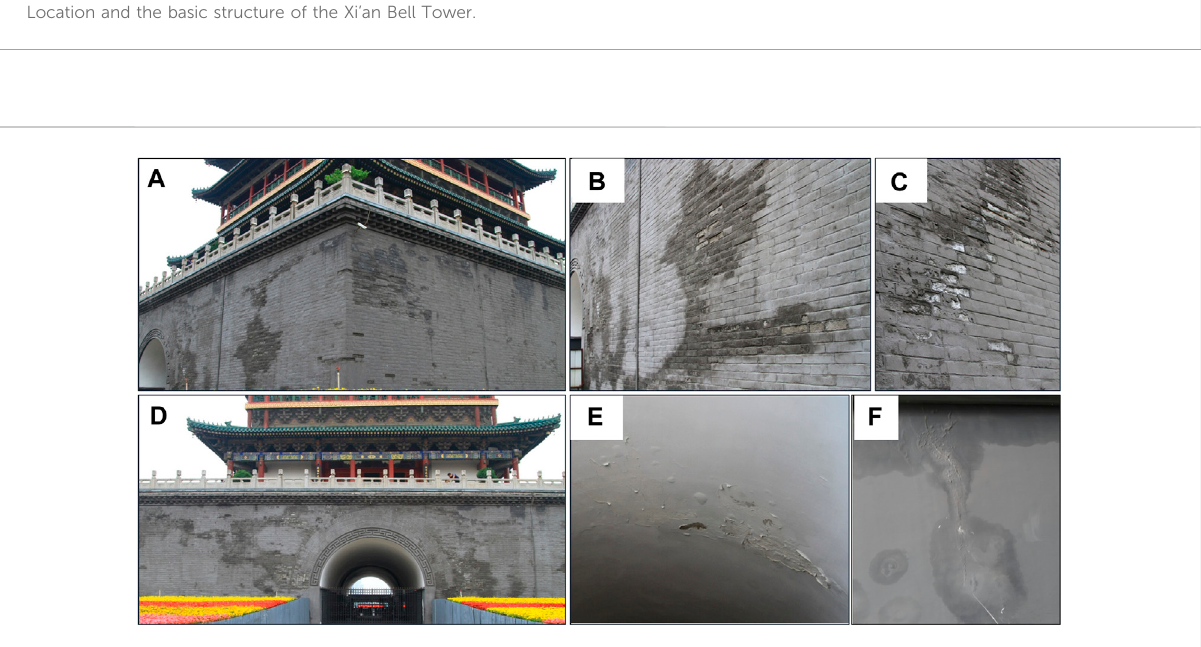
FIGURE 2 Waterseepage ontheexteriorwalloftheXi ’ anBellTowerpedestal (A) thesouthwestcorner; (B) thewest pedestal; (C) calciumprecipitates; (D) the south pedestal; (E) the west archway; and (F) the east